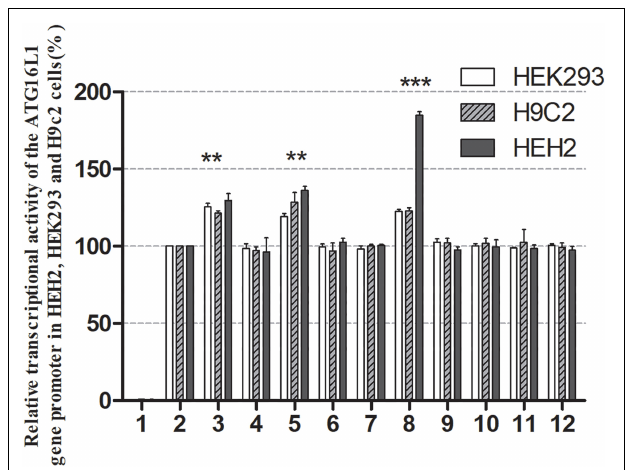
FIGURE 4 | Relative transcriptional activity of wild-type and variant ATG16L1 gene promoters. Wild-type and variant ATG16L1 gene promoters were cloned into reporter gene vector pGL3 and transfected into cultured cells. The transfected cells were collected, and dual-luciferase activities were assayed. Empty vector pGL3-basic was used as a negative control. The transcriptional activity of the wild-type ATG16L gene promoter was designed as 100%. The relative activities of the ATG16L1 gene promoter were calculated. Relative activities of wild-type and variant ATG16L1 gene promoters in HEK-293, H9c2 and HEH2 cells. Lanes 1, pGL3-basic; 2, pGL3-WT; 3, pGL3-233250693C; 4, pGL3-233250873A; 5, pGL3-233250946A; 6, pGL3-233251039C; 7, pGL3-233251111T; 8, pGL3-233251133G; 9, pGL3-233251186G; 10, pGL3-233251524C; 11, pGL3-233251563T, and 12, pGL3-233251699G. **